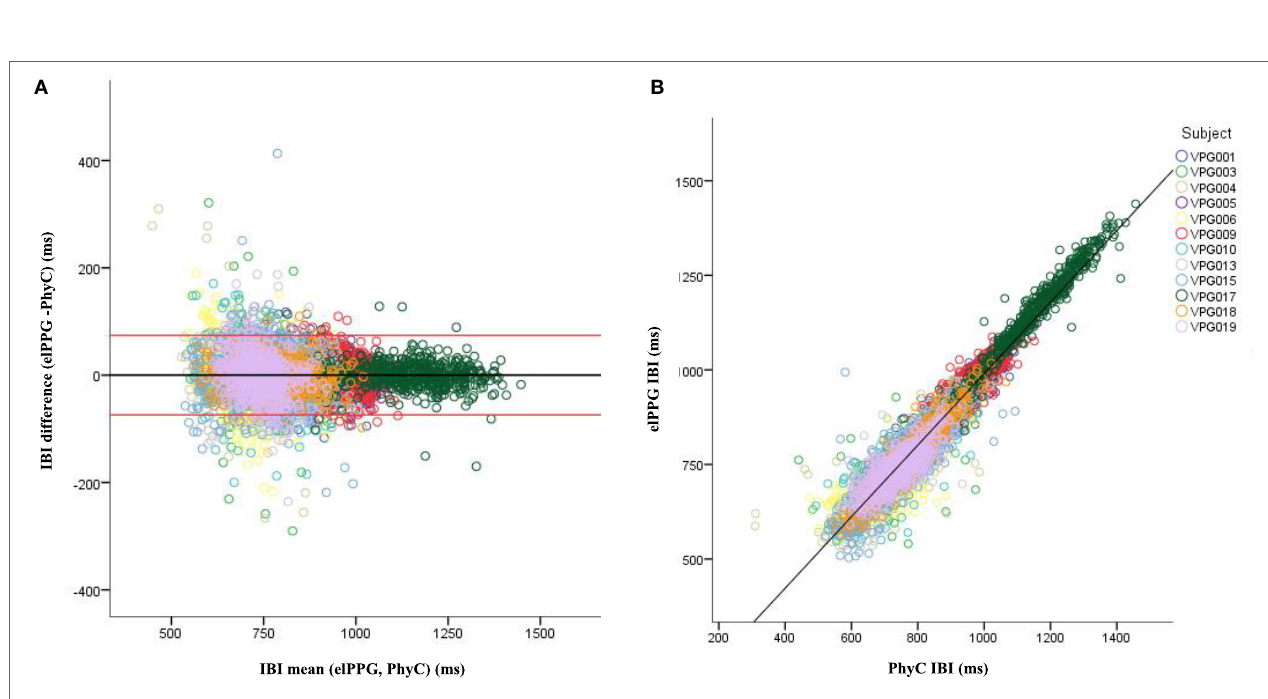
FigUre 3 | Bland–Altman and scatter plot for interbeat interval (IBI) from the electrocardiogram (ECG) and PhysioCam (PhyC), color coded by participant. (a) Plot of the IBI differences vs the means for the ECG and PhyC. Red lines indicate the 95% confidence interval. (B) Scatter plot of the PhyC vs ECG